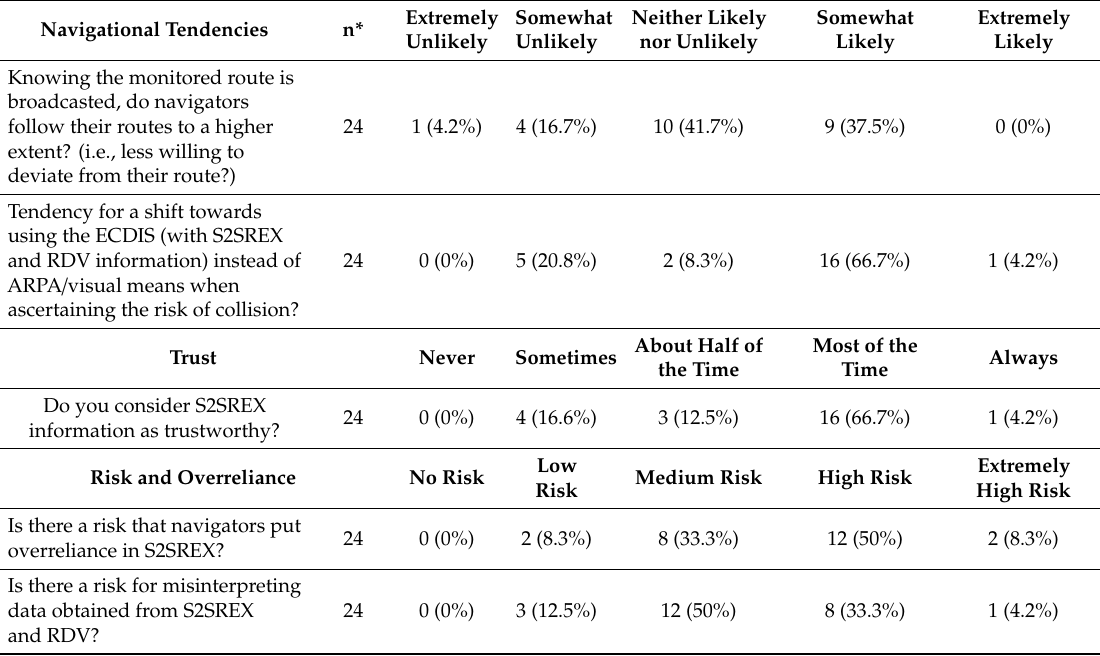
Table 3. Summary of end of the day questionnaire